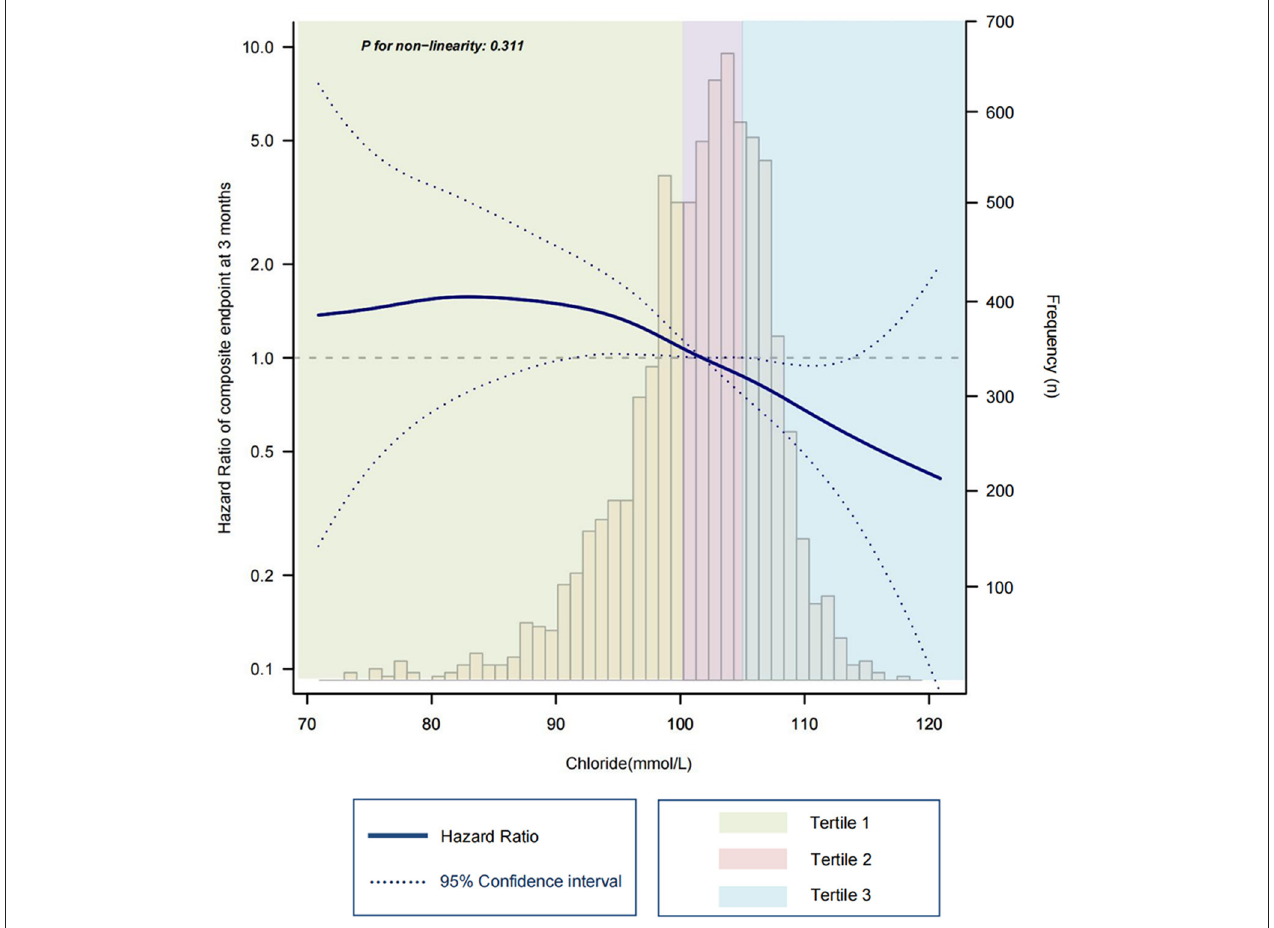
FIGURE 2 | Spline plot for the associations of serum chloride with composite endpoint risk at 3 months. Hazard ratio (solid line) and 95% confidence intervals (dashed line) are estimated in a Cox proportional hazards model with adjustment for age, sex, NYHA class, diabetes, log BNP. Frequency bars show the proportion of patients with a specific chloride